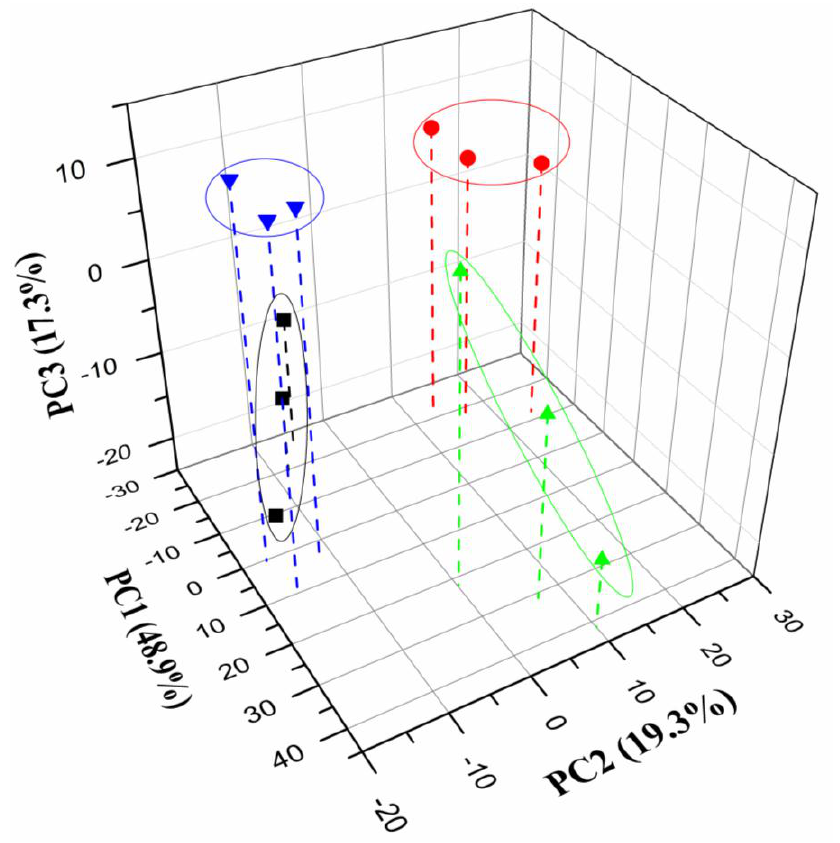
Figure 3. PCA score 3D plots of commercial (Elegê ® ) whole milk samples, unadulterated (black squares), and adulterated with 10.0 mmol·L −1 of formaldehyde (red circles), 0.95 mmol·L −1 of melamine (blue up triangles), and 4.16 mmol·L −1 of urea (green down triangle). Samples were analysed in